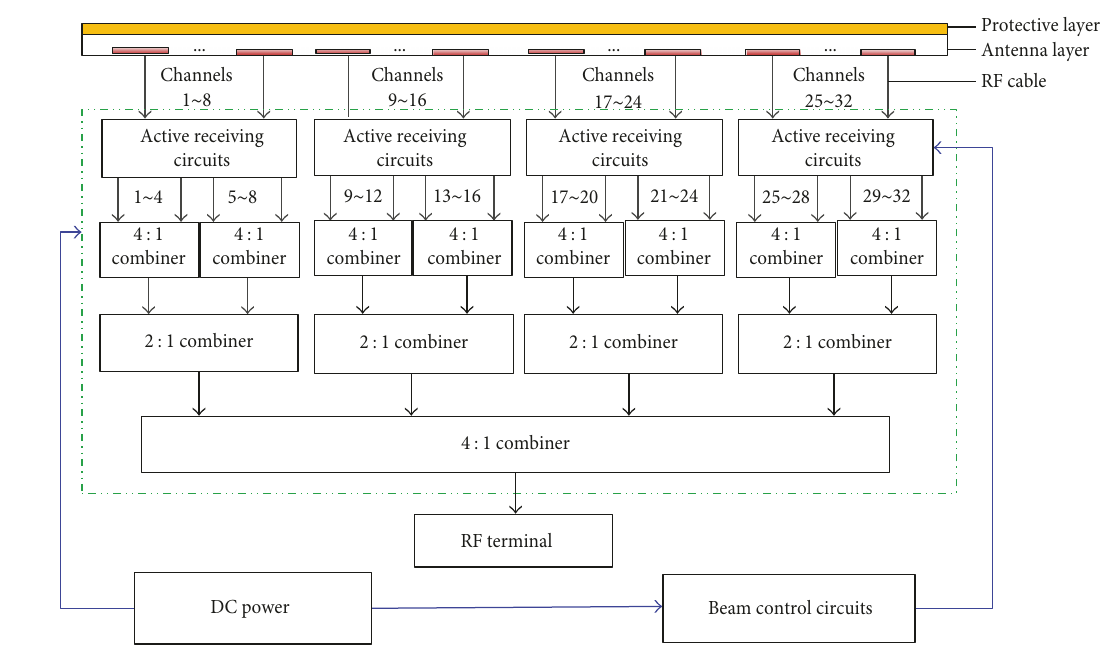
Figure 10: Block diagram of information transmission of smart skin antenna